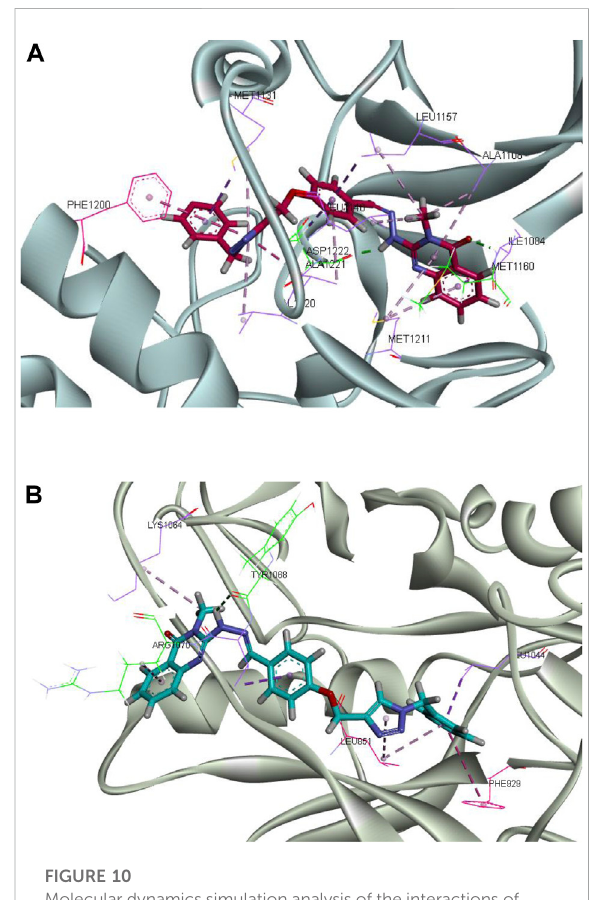
FIGURE 10 Molecular dynamics simulation analysis of the interactions of CM9 with MET and FLT4 (VEGFR3). Molecular dynamics (MD) simulation analysis of CM9 with MET (A) and FLT4 (VEGFR3) kinases (B) were perfrormed with Gromacs software. Van der Waals, hydrogen bond, pi – pi and pi – sulfur interactions were colored as light purple, light green, light pink and orange. Images were created by Discovery Studio Client